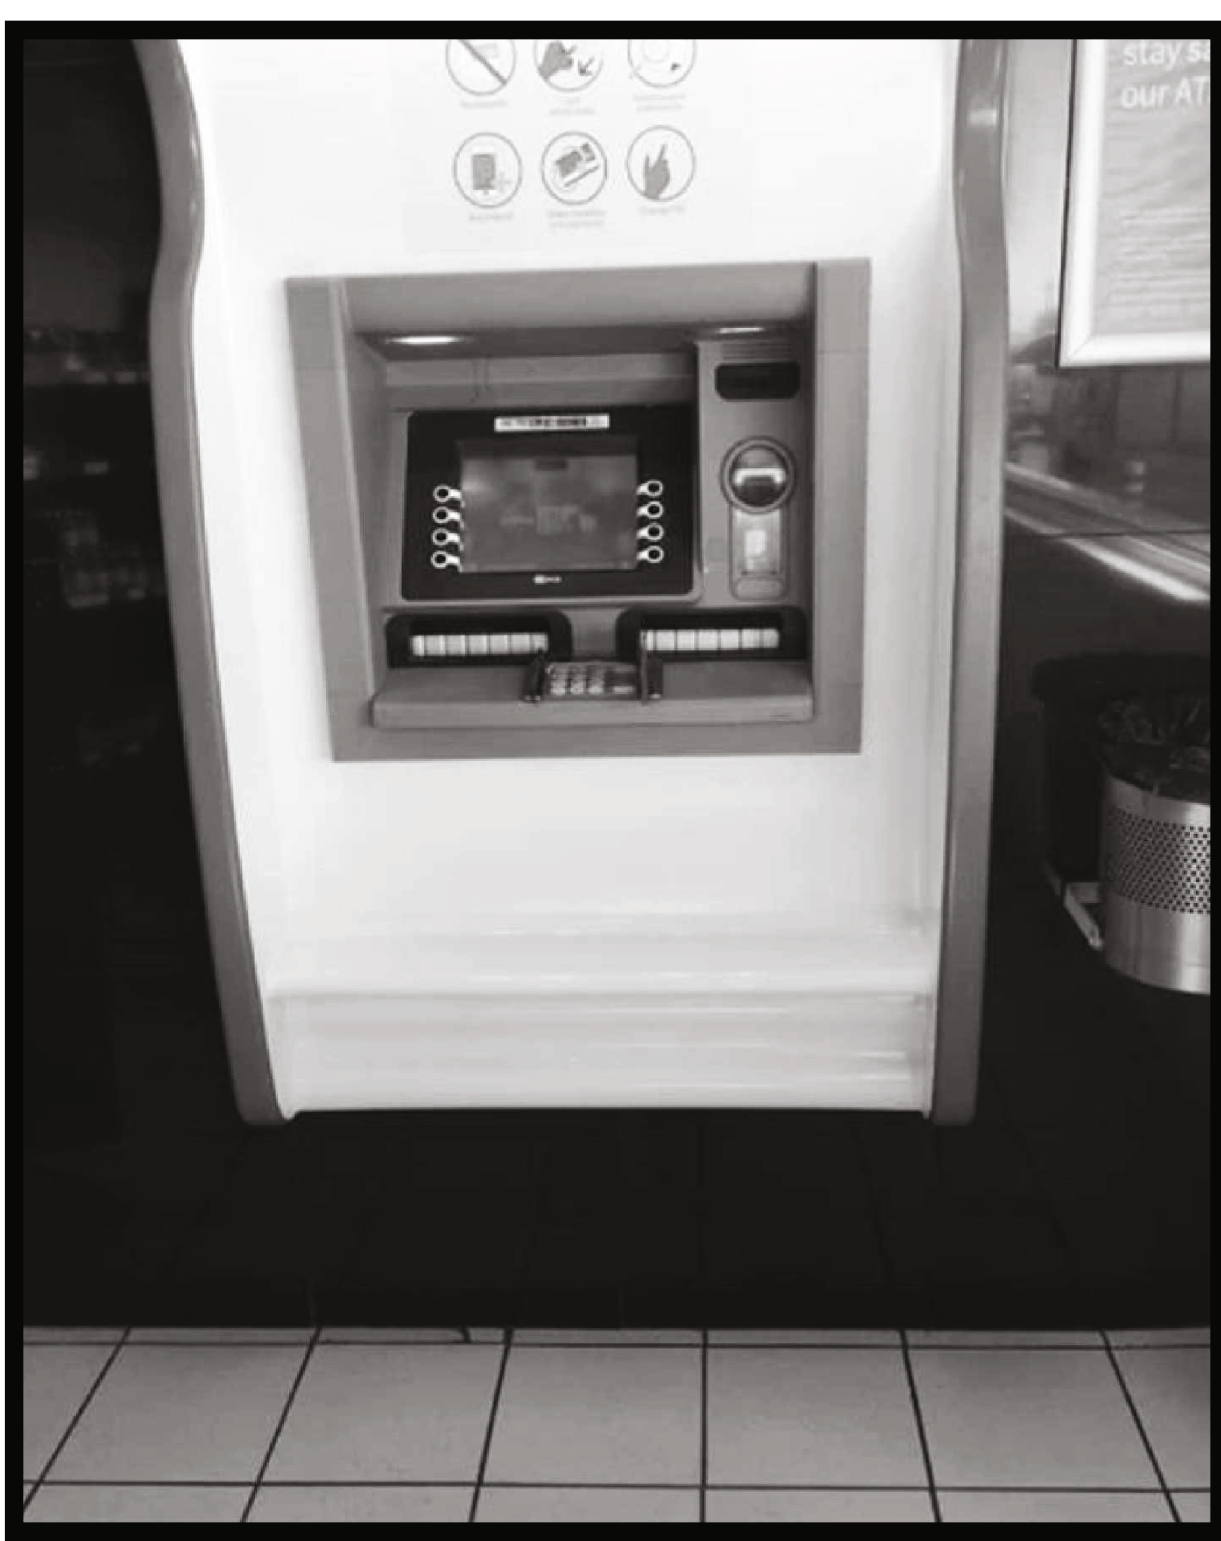
Figure 2: Automated teller machine that is not user friendly to persons with visual impairment ( fi gure recoloured to prevent identi fi cation of the service